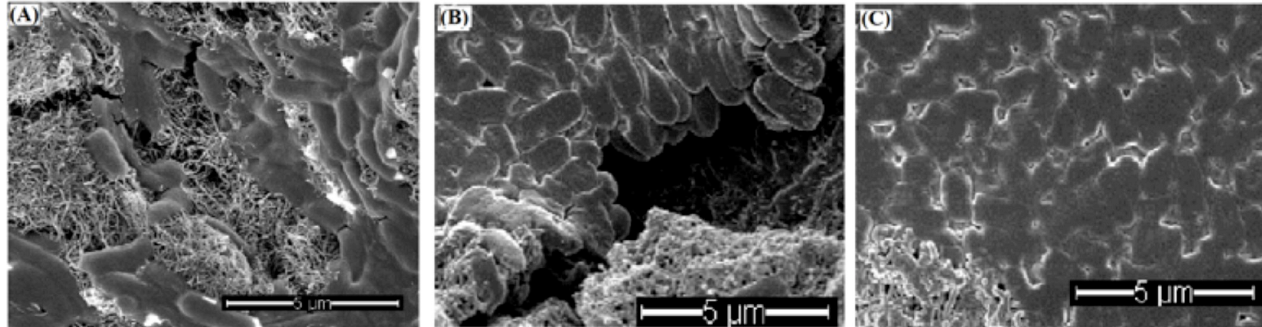
Fig 4. SEM images of E . coli cells on (A) a MWCNTs filter, (B) a LEO-MWCNTs filter, and (C) a TTO-MWCNTs filter. The filters were prepared by coating 50 μ L LEO and 50 μ L TTO on MWCNTs filters.